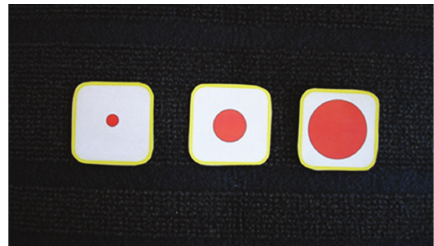
Figure 2: Three circles of di ff erent sizes (small, medium, and large).